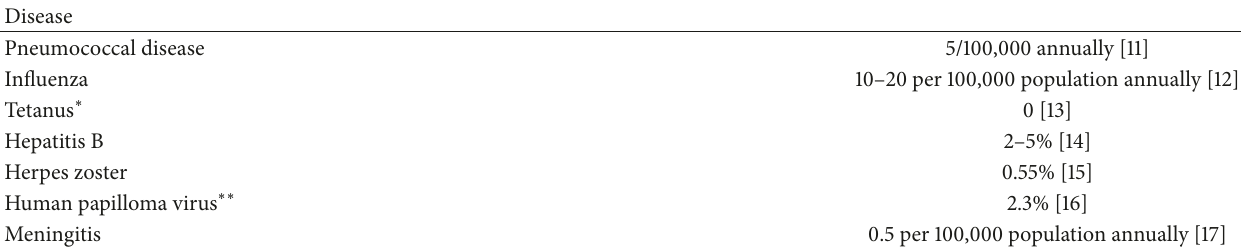
Disease Pneumococcal